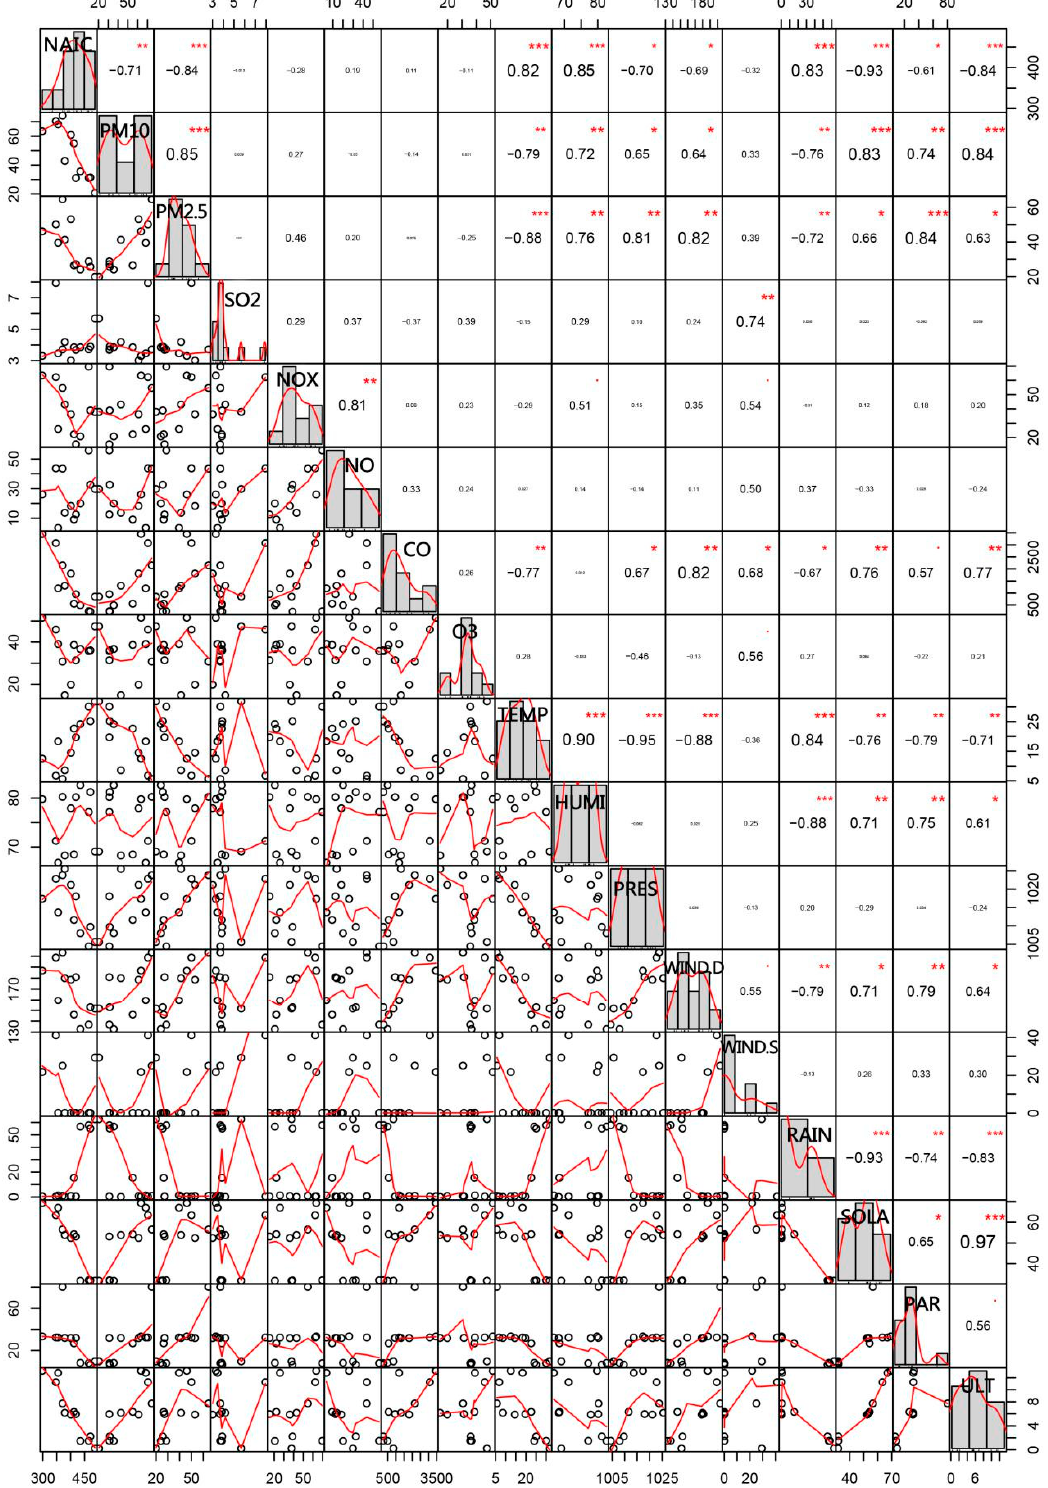
Figure 4. Factor correlation analysis matrix. ***: p < 0.001, **: p < 0.01, *: p < 0.05. The more significant, the larger the characters.